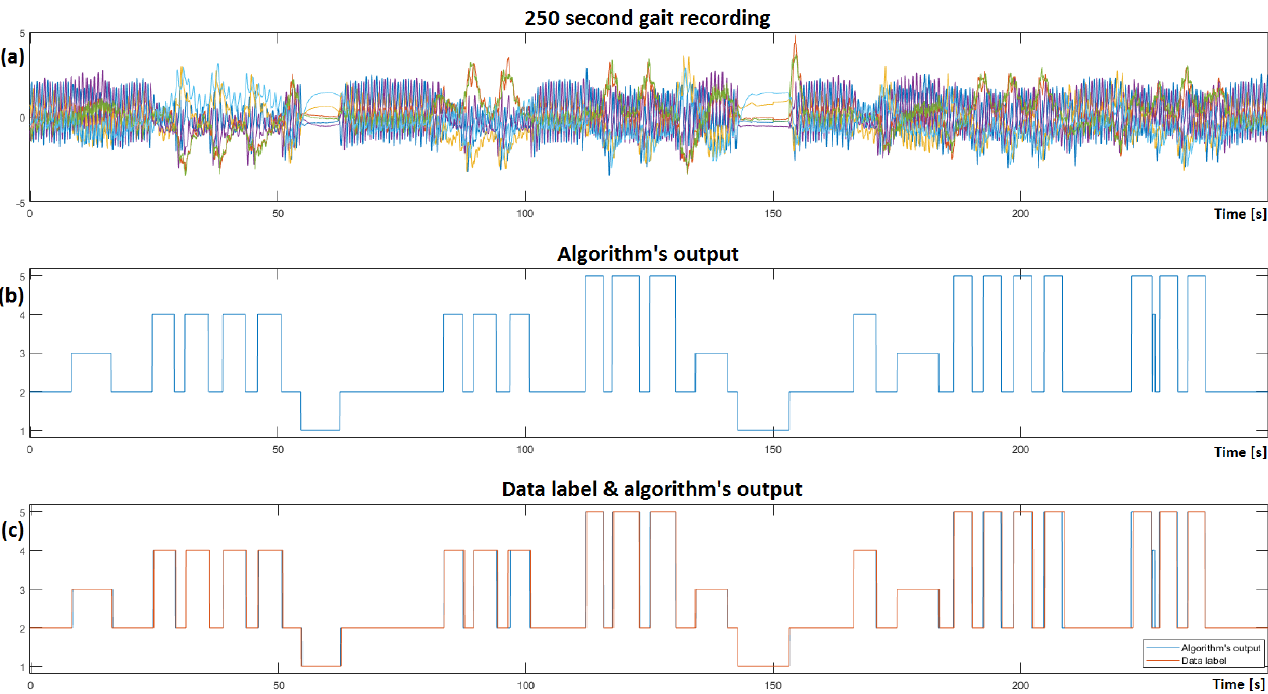
Figure 10. Visualization of the CNNA + RNN algorithm’s output on a test RAW 250 s gait recording; ( a ) Complementary filter information from ‘unseen’ gait dataset visualized; ( b ) illustrates the algorithm’s output on the ‘unseen’ dataset; ( c ) presents a comparison of the data label and algorithm’s output. Table 9. CWT dataset